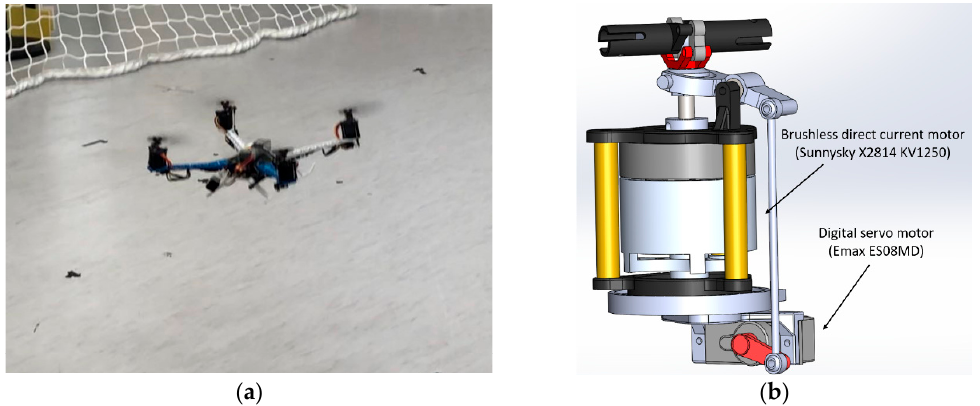
Figure 10. ( a ) Quadrotor flight test platform with the VPP system; ( b ) CAD drawing of the VPP mechanism.